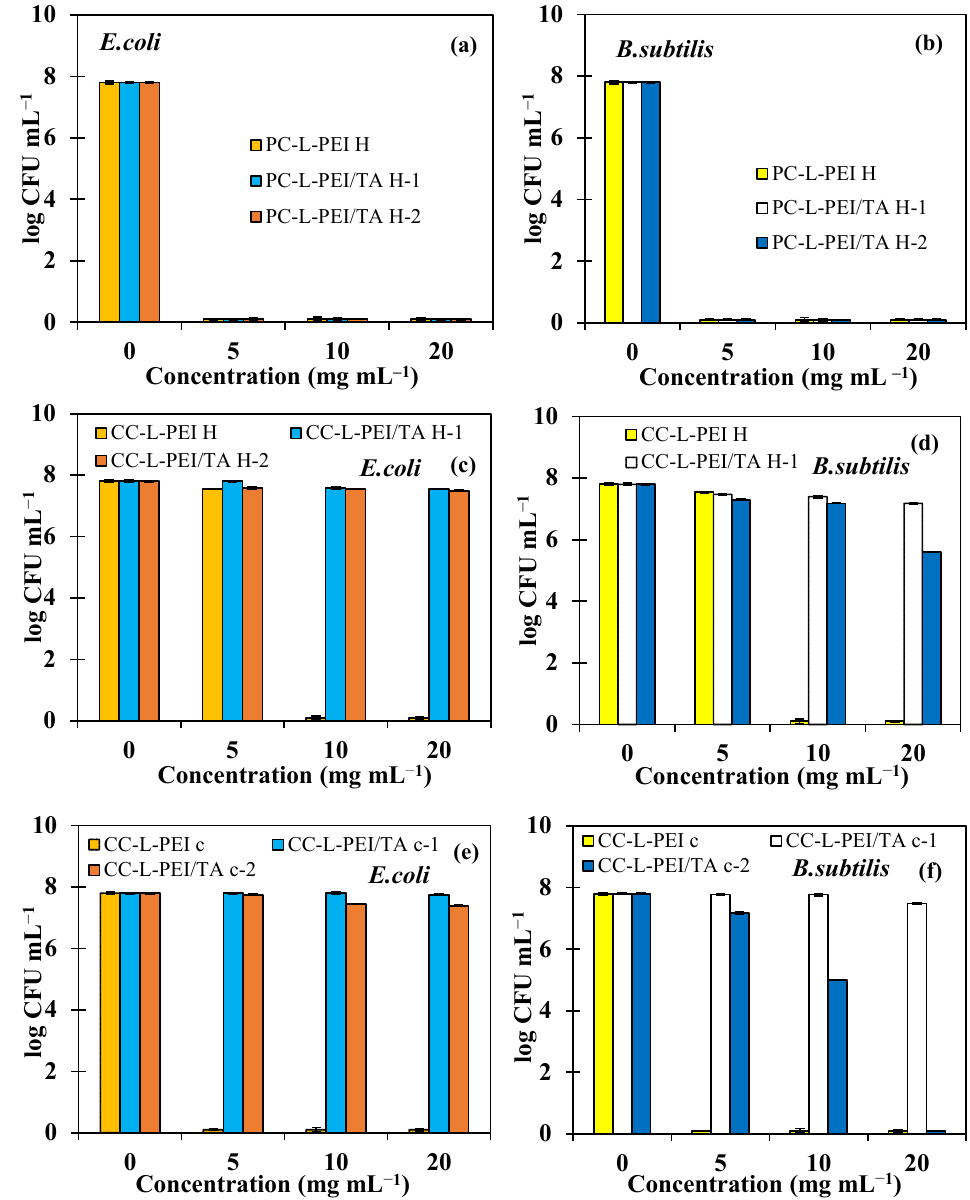
Figure 5. Antibacterial activities of PC-L-PEI H-based materials against ( a ) E. coli ( b ) S. aureus , CC-L-PEI H-based materials against ( c ) E. coli ( d ) S. aureus , and CC-L-PEI C-based materials against ( e ) E. coli ( f ) S. aureus are illustrated as bacterial growth numbers (log colony forming units (CFU)/mL). In the macro-dilution test, the growth inhibitory effects of the prepared materials at 5, 10, and 20 mg/mL concentrations were evaluated within 24 h of incubation. Hence, the observed antibacterial effects were directly related to the released amount of TA from the materials. Materials with a rapid TA release profile were expected to exhibit higher antibacterial activity. The results are illustrated in Figure 5 as the number of bacteria colonies for Gram-negative E. coli and Gram-positive B. subtilis bacteria strains. As can be seen in Figure 5a,b, PC-L-PEI H , PC-L-PEI/TA H -1, and PC-L-PEI/TA H -2 samples, even at 5 mg/mL concentration, killed >99% of both bacteria strains and were determined as MBC. As shown in Figure 5c,d, CC-L-PEI H at 5 mg/mL concentration killed 50% of both bacteria strains and was determined as the MIC value, whereas the same material at 10 mg/mL killed >99% of both strains and was determined as the MBC value.